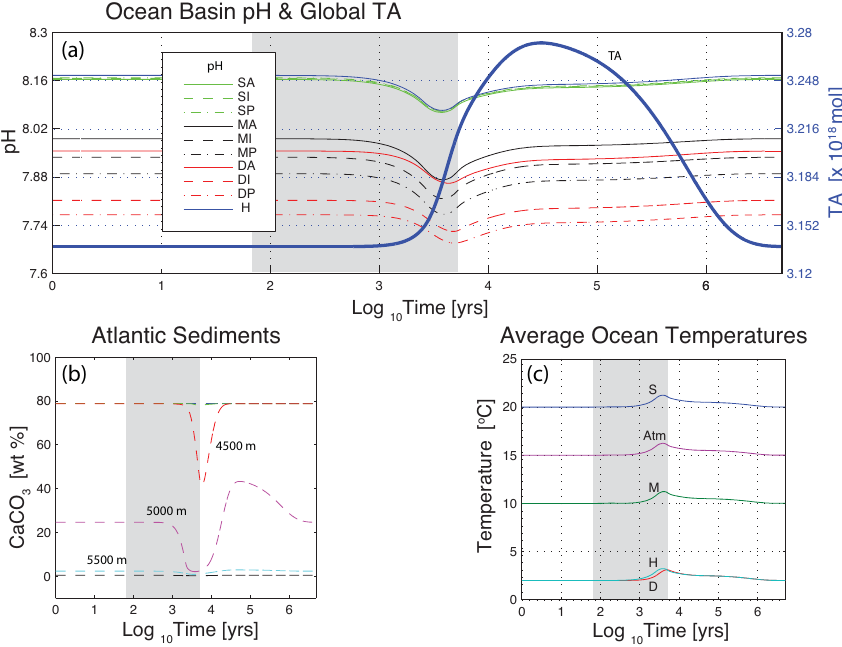
Figure 4. System variables as a function of time for the case of E = 1000PgC and D = 5kyr. Shaded regions indicate time of emission. (a) Thin lines are pH for the surface (S), intermediate (M), and deep (D) ocean boxes in the Atlantic (A), Indian (I), and Pacific (P) basins. Thick solid line is the global ocean total alkalinity (TA). (b) CaCO 3 wt% of sediment boxes within the Atlantic Basin. (c) Temperature for atmosphere (Atm) and high-latitude boxes (H). Surface (S), intermediate (M), and deep (D) ocean temperatures are averages across basins..